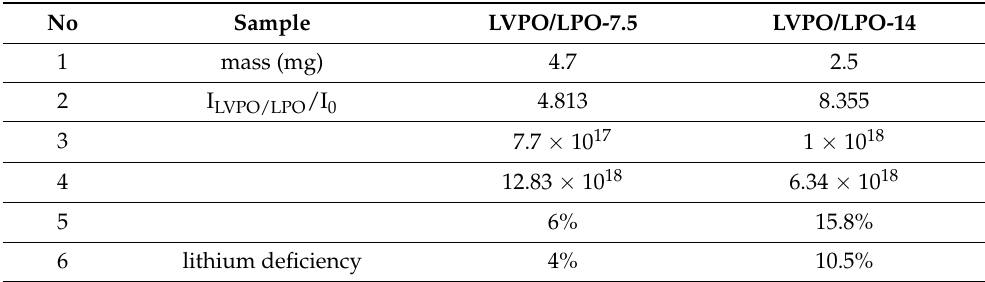
Table 2. ESR spectra integral intensity ratio I LVPO/LPO /I 0 , number of magnetic centers, total num- ber of vanadium ions, relative number of tetravalent vanadium ions and lithium deficiency for Li 3 V 2 (PO 4 ) 3 /Li 3 PO 4 composites. No